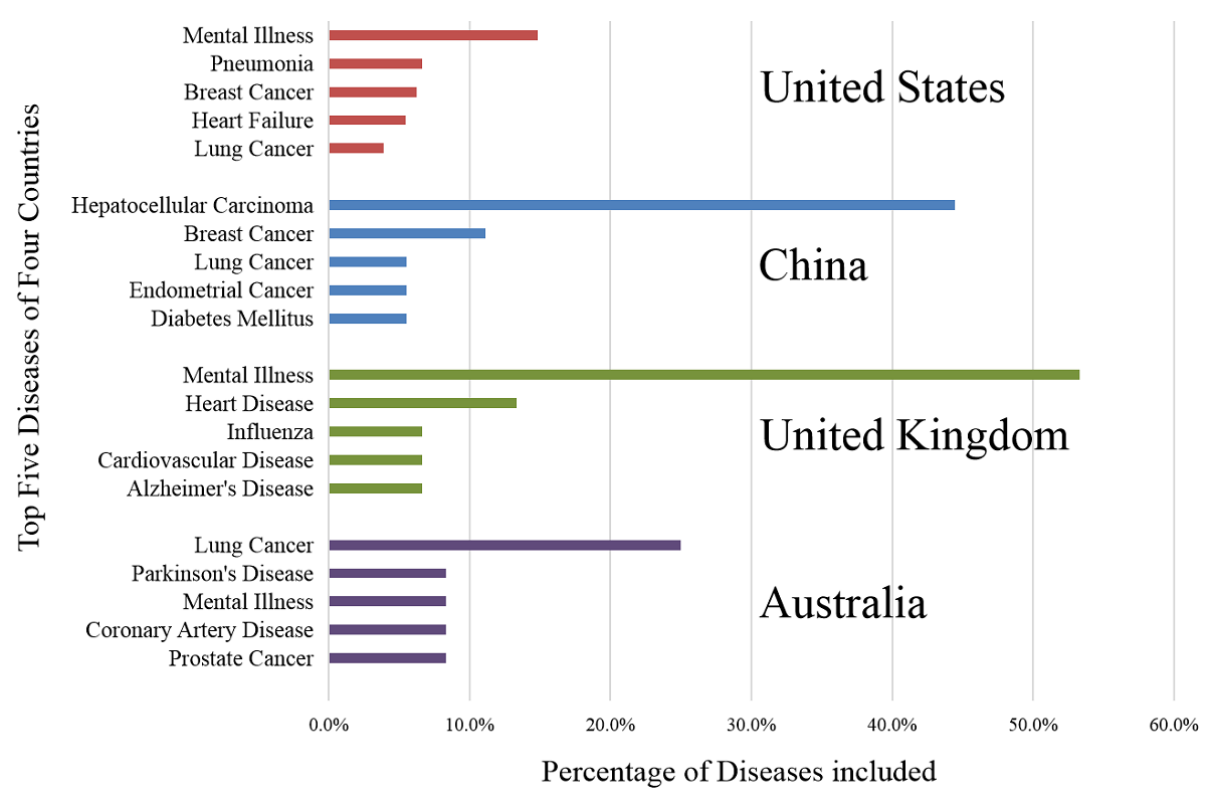
Figure 8. Distribution of diseases in studies that used natural language processing for the investigation of disease cases in the United States, China, United Kingdom, and Australia.